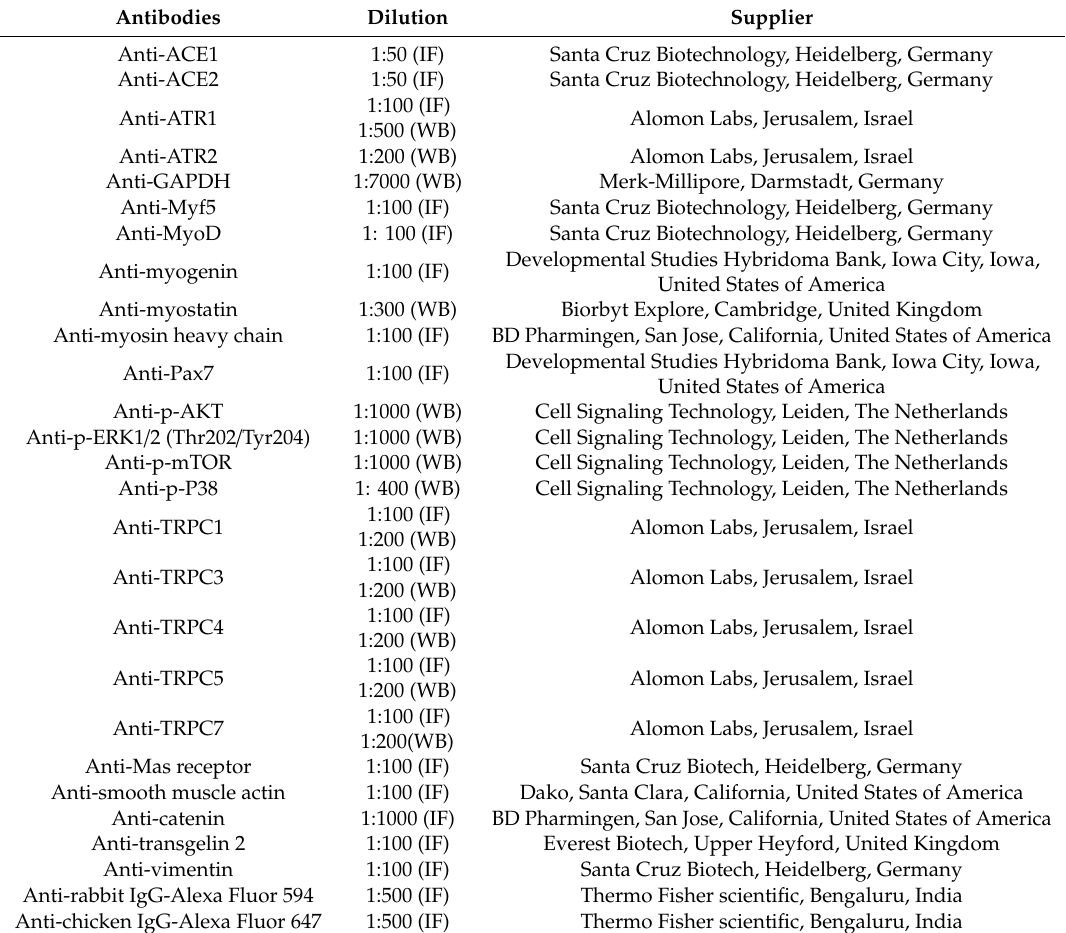
Table 1. List of primary and secondary antibodies used for immunofluorescence (IF) and western blot (WB)